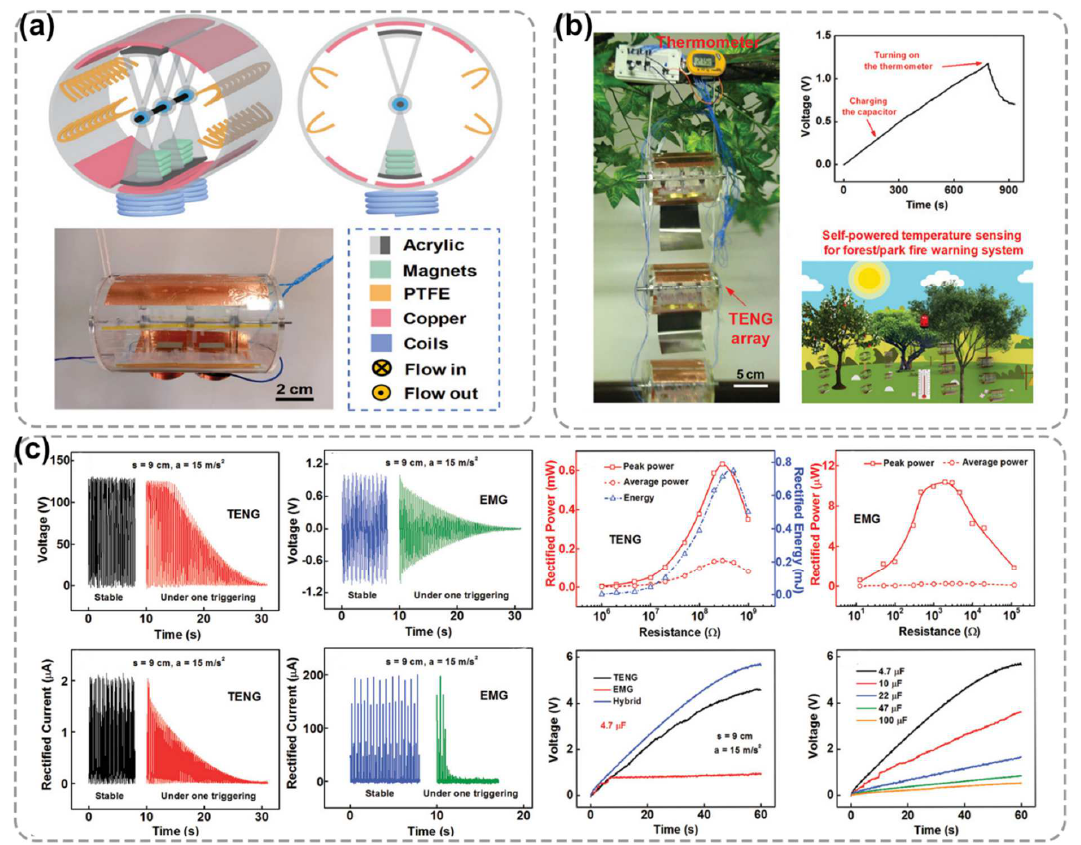
Figure 8. ( a ) A swinging breeze collection system consisting of EMG and TENG. ( b ) Photograph of a digital thermometer powered by a SS–TENG array under the wind triggering. ( c ) Output performance of the TENG part and EMG. Reproduced with permission of [83], Copyright 2021, John Wiley and Sons.